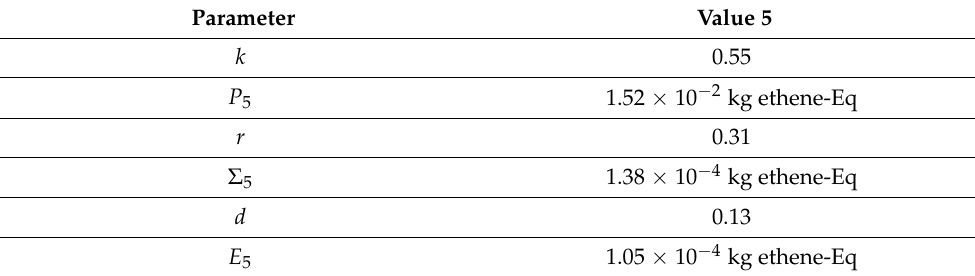
Table 5. Parameter values of the photochemical ozone creation potential.